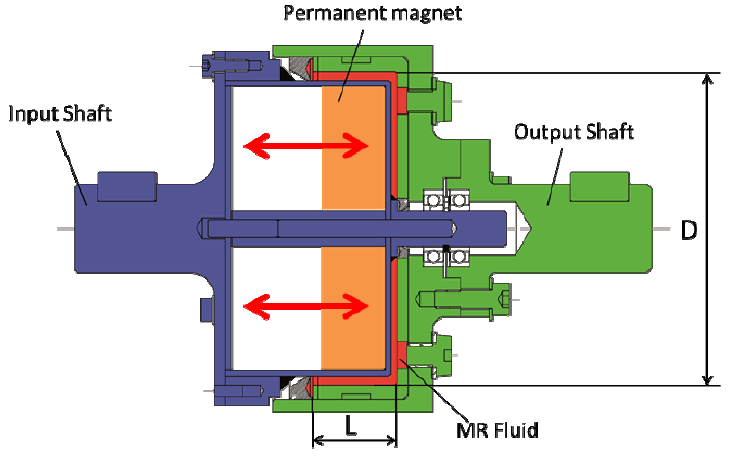
Figure 5: Prototype scheme.